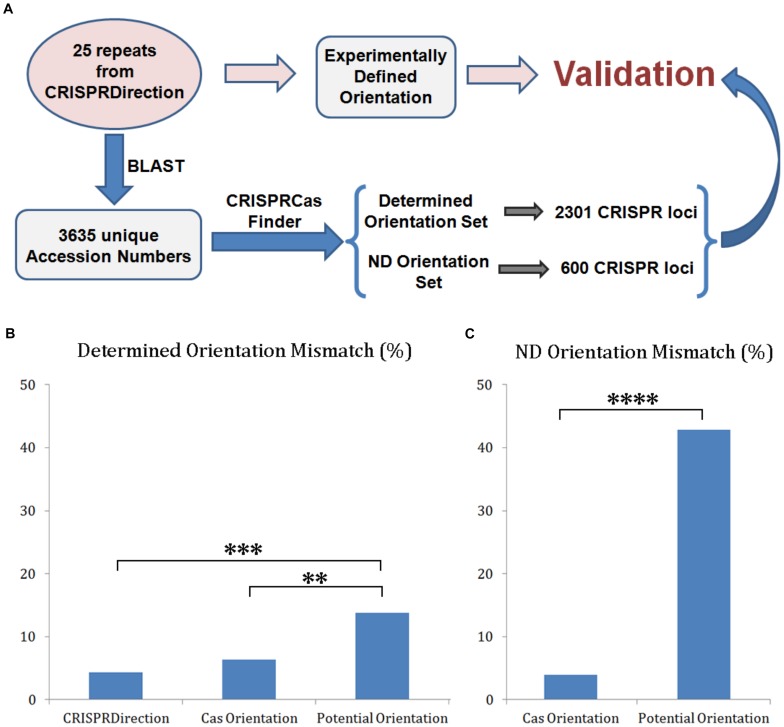
(A) Validation protocol for CRISPR array orientation predictors accuracy; (B) Distribution of mismatches between the investigated predictors (CRISPRDirection, Potential Orientation, and Cas Orientation) vs. Determined Orientation Set (∗∗∗∗P < 0.0001). (C) Distribution of mismatches between Potential Orientation and Cas Orientation vs. ND Orientation Set.